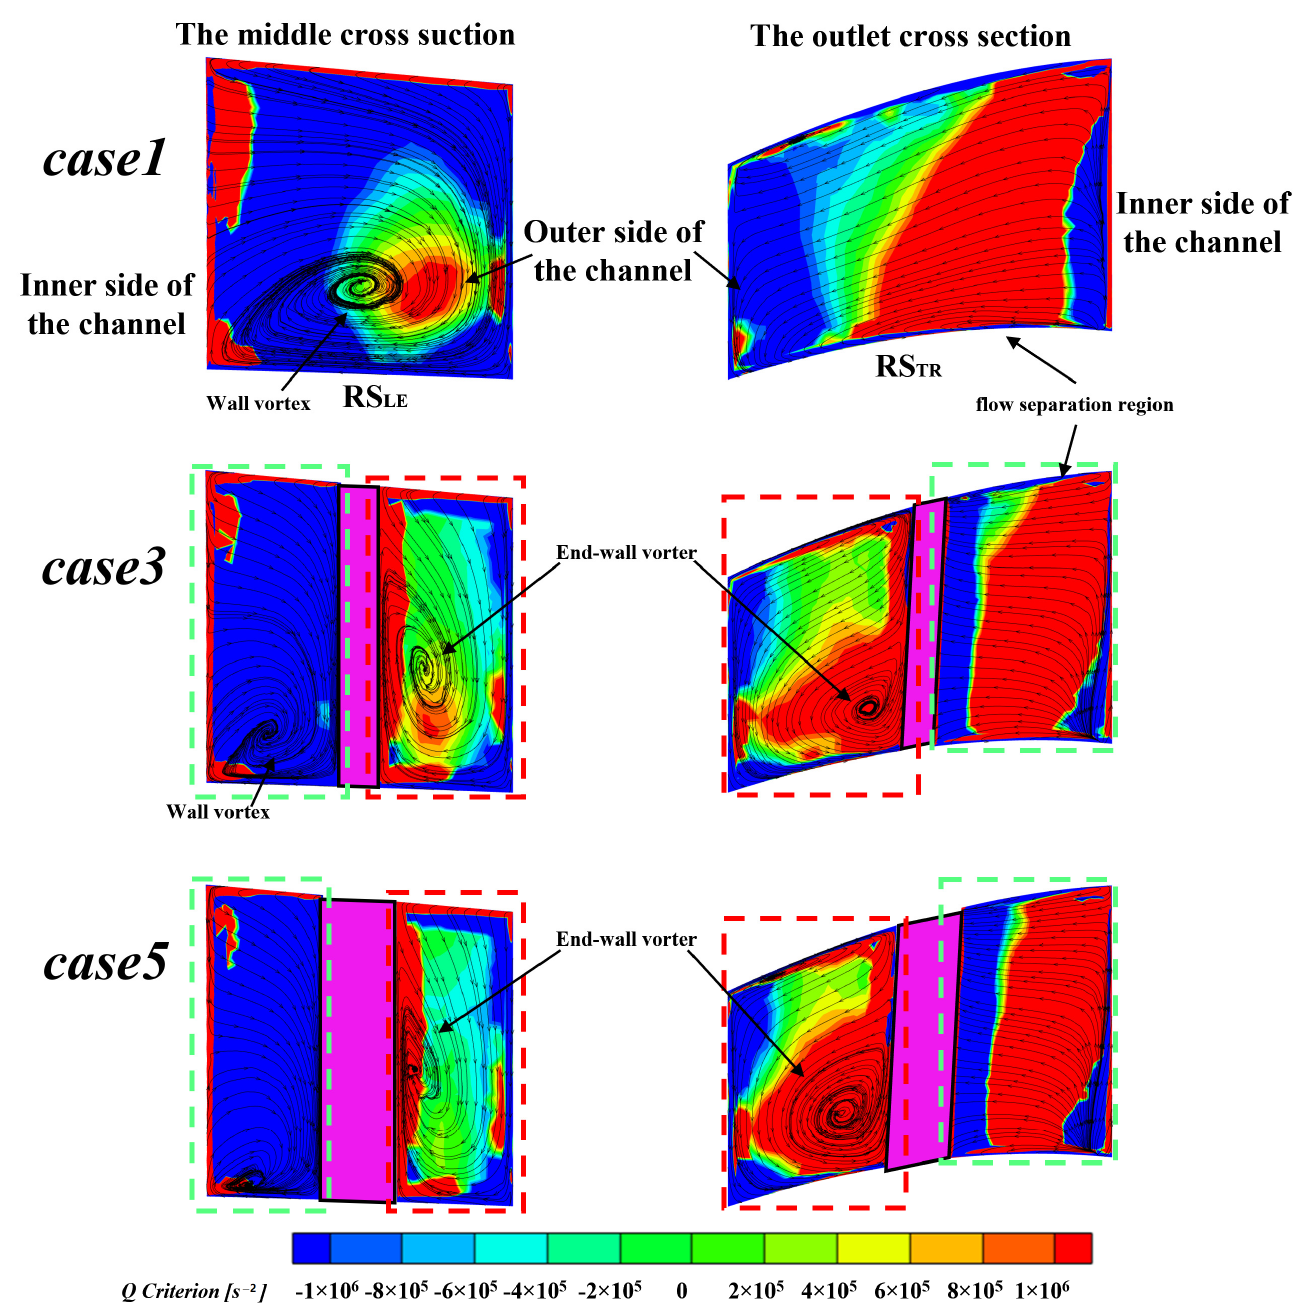
Figure 14. The vorticity based on Q criterion and streamline counters of the first turning region, Ro = 0.4. Ro =